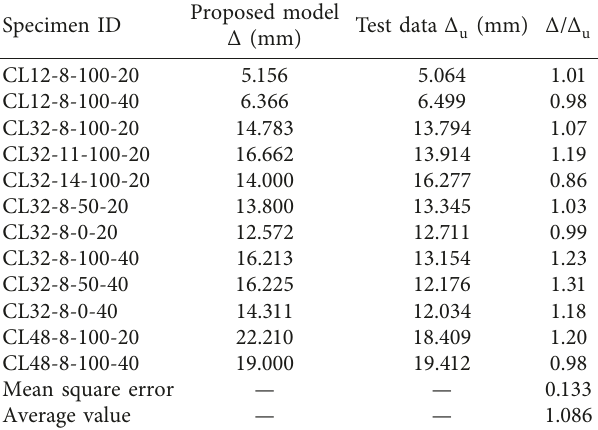
Table 7: Comparisons of the deflection values predicted by the proposed equation and test data of the reference.